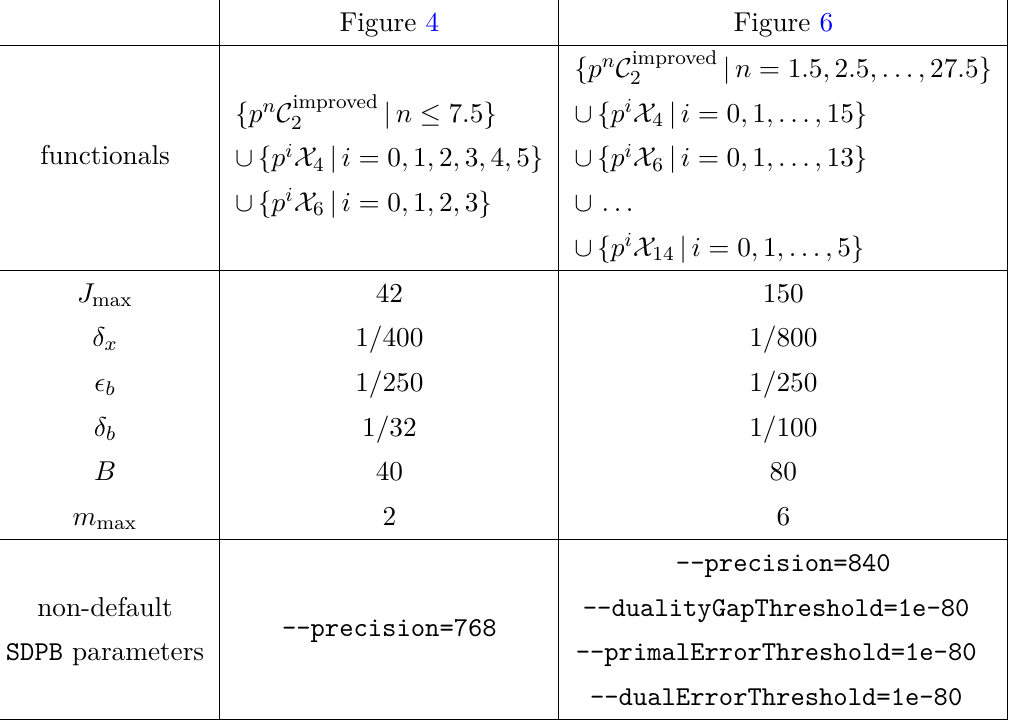
Table 2 . Choices of parameters for the computations in this work. These parameters were chosen experimentally — we have not attempted to optimize them. For the computation in figure 4,